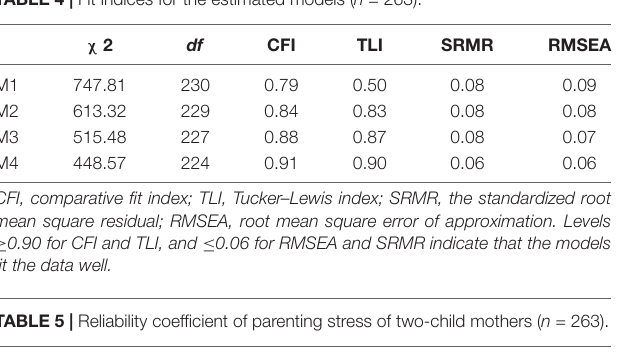
TABLE 4 | Fit indices for the estimated models ( n = 263).